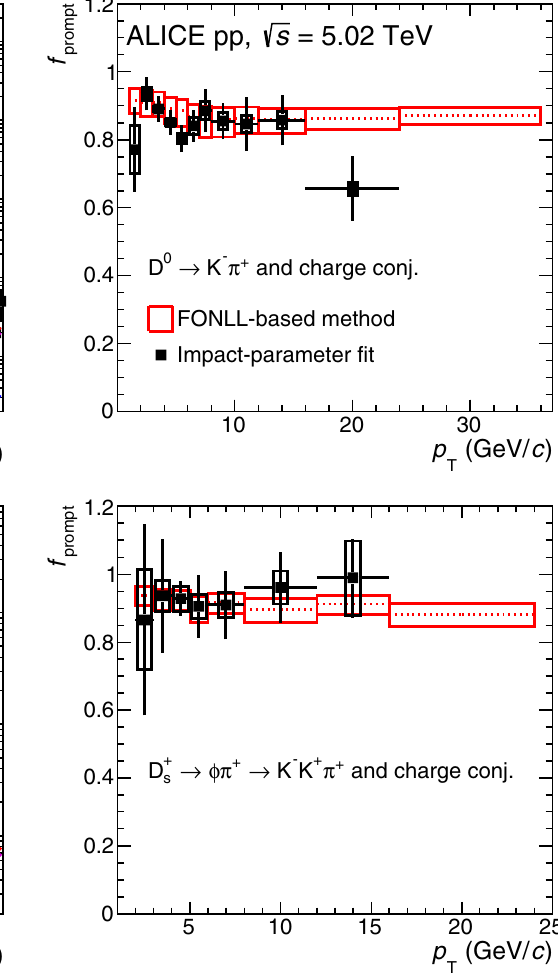
FONLL-based approach. The results from the data-driven method are shown as square markers with the error bars (boxes) representing the statistical (systematic) uncertainty. The central values of f prompt from the FONLL-based approach are shown by the dashed line and their uncertainty by the red